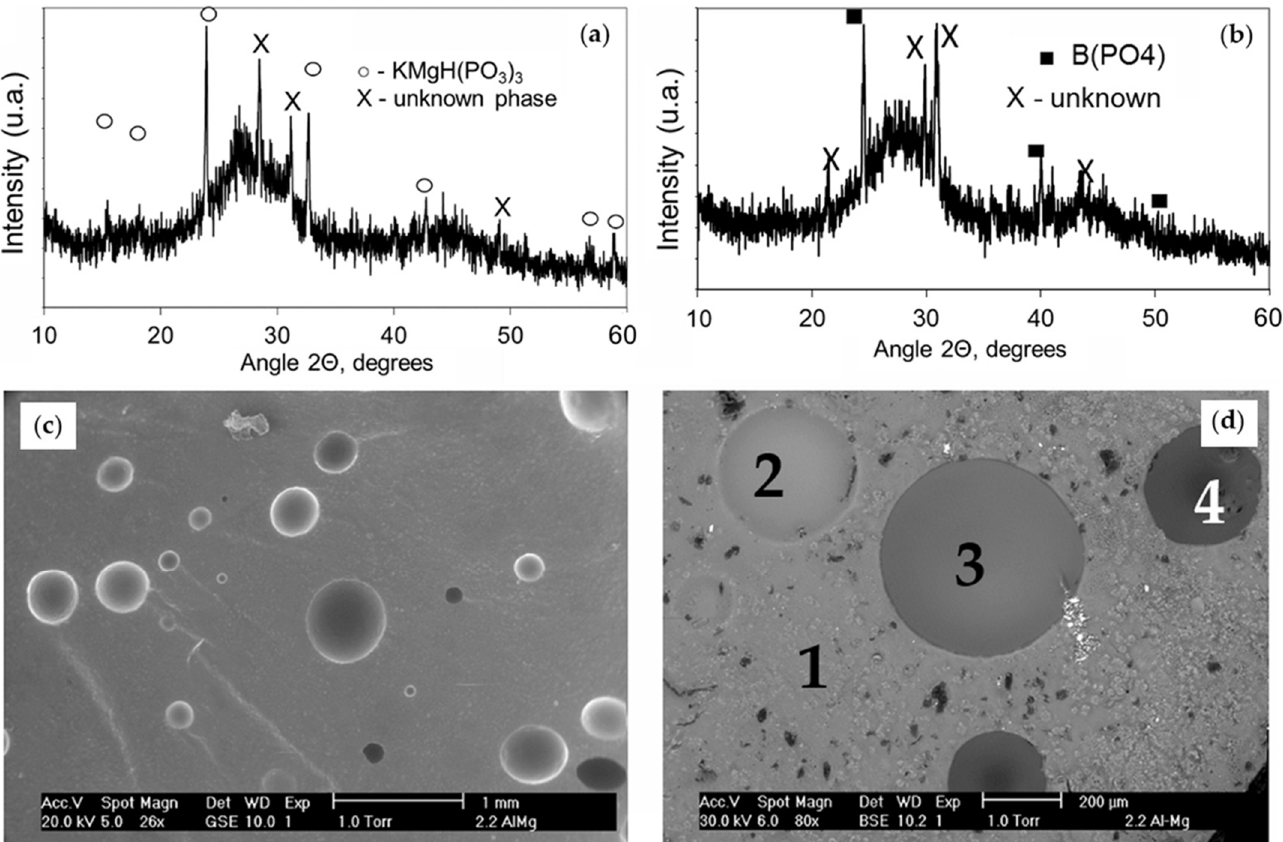
Figure 3. XRD pa tt erns ( a , b ) and electron images ( c , d ) of the materials based on the compositions 1AM ( a , c ) and 1AMB ( b , d ). X—unknown crystalline phases. Chemical composition in point 1–4 presented in the Table 4. Table 4. Chemical composition of different vitreous phases in glass 1AMB, in accordance with the data of low-energy EDS analysis (at.%, without oxygen). The points are marked in Figure 3. Relative Contents, Chemical Elements